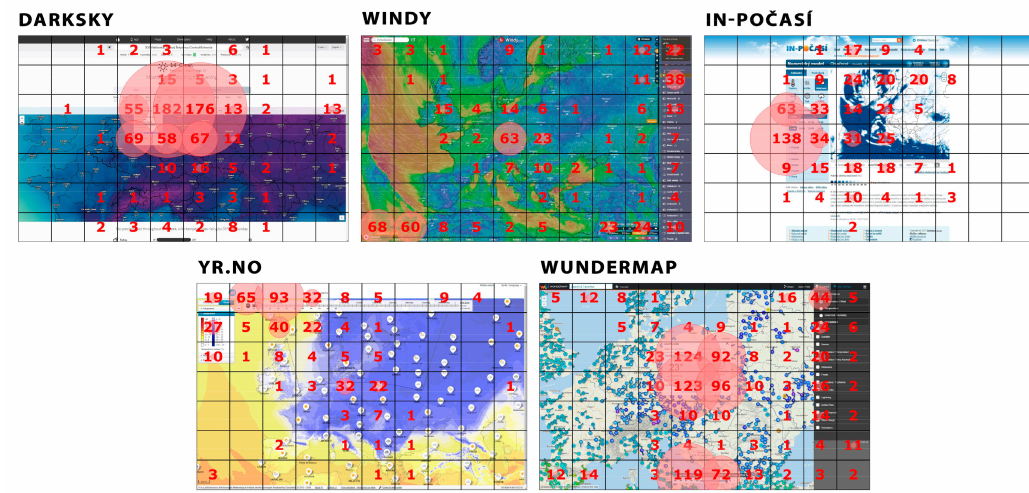
Figure 13. Number of fixations recorded in the regular grid overlaying the stimuli in Static – Task 1.